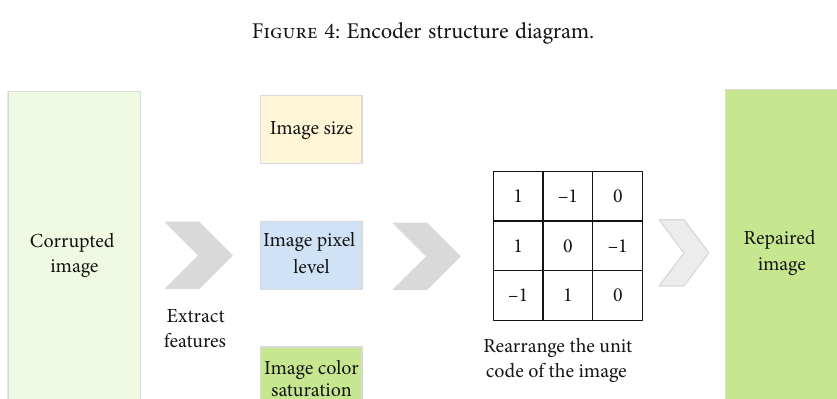
Figure 4: Encoder structure diagram.